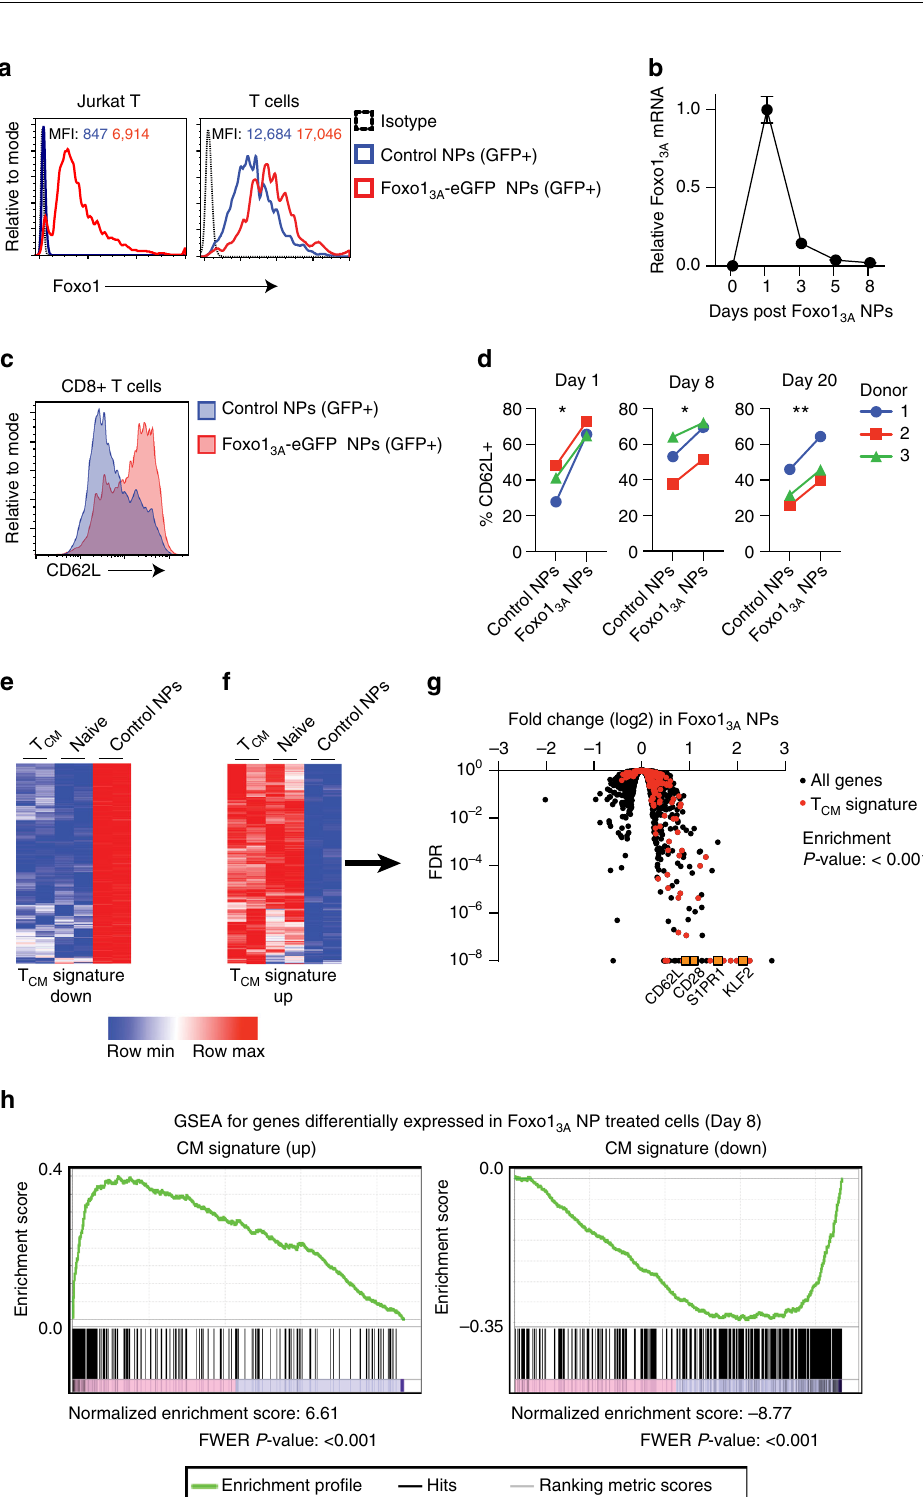
Fig. 4 Nanoparticles can induce markers and transcriptional patterns characteristic of memory T-cells. a Expression of total Foxo1 protein measured by intracellular labeling in Jurkat and primary T-cells treated with CD3-targeted control (GFP+) or Foxo1 3A -GFP NPs. Mean Foxo1 fl uorescence intensities (MFI) for cells transfected with control NPs (shown in blue ) compared to Foxo1 3A -NPs (shown in red ) are indicated above the respective histograms. b qPCR measurements of relative Foxo1 3A mRNA expression over time after cells were exposed to Foxo1 3A -eGFP nanoparticles (NPs). Data are representative of two independent experiments. Graphs show mean ± SE. c Effect of CD8-targeted Foxo1 3A -GFP NPs on CD62L expression after 24 h of particle treatment. d Percentage of CD62L + cells in sorted CD8 + eGFP + cells treated with CD8-targeting control or Foxo1 3A /eGFP-encoding NPs at 1, 8, and 20 days of culture after the particles were introduced. These results are from three independent donors. * P < 0.05; ** P < 0.01 between the indicated conditions as calculated from a ratio-paired t -test. e , f Heat maps of T CM signature gene expression in T CM , naive, and control cells 8 days after treatment. g Volcano plot of differential gene expression in Foxo1 3A -NP-treated cells after 8 days. T CM signature genes and selected memory phenotype genes are indicated. P value of overlap between Foxo1 3A and the T CM signature gene set was determined by GSEA (via analysis shown in h